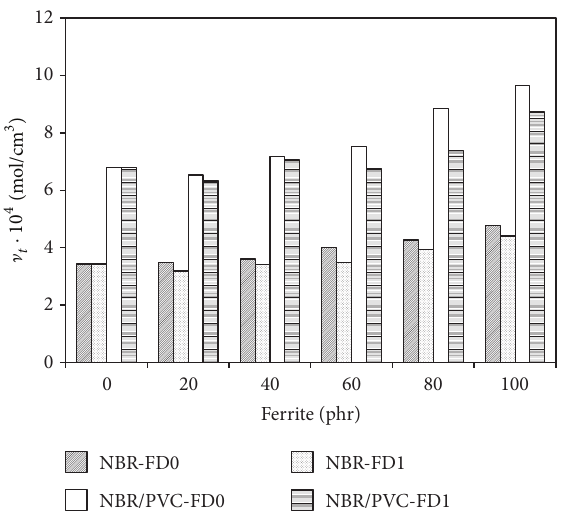
Figure 5: Influence of ferrites content on total cross-link density ] 𝑡 of composites.